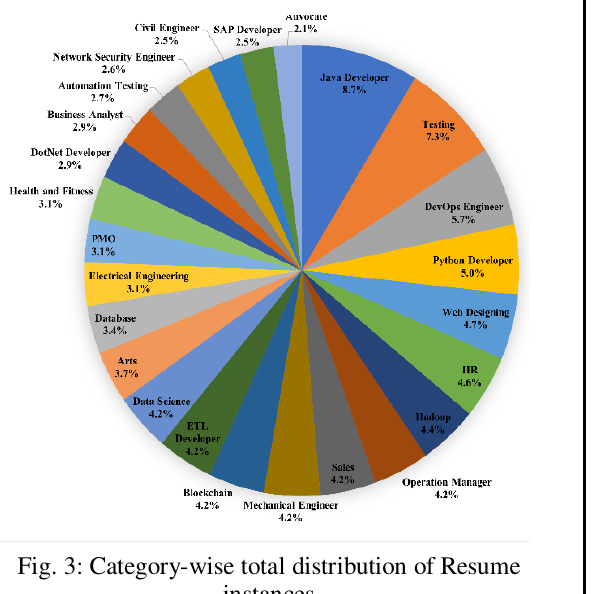
Fig. 3: Category-wise total distribution of Resume